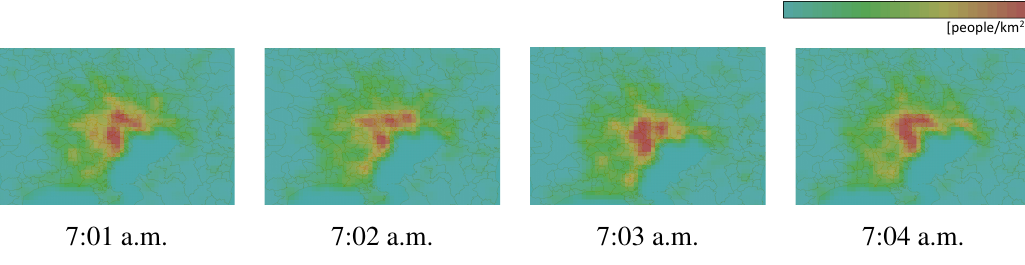
Figure 10. Visualized distributions by the Gaussian-kernel estimator after